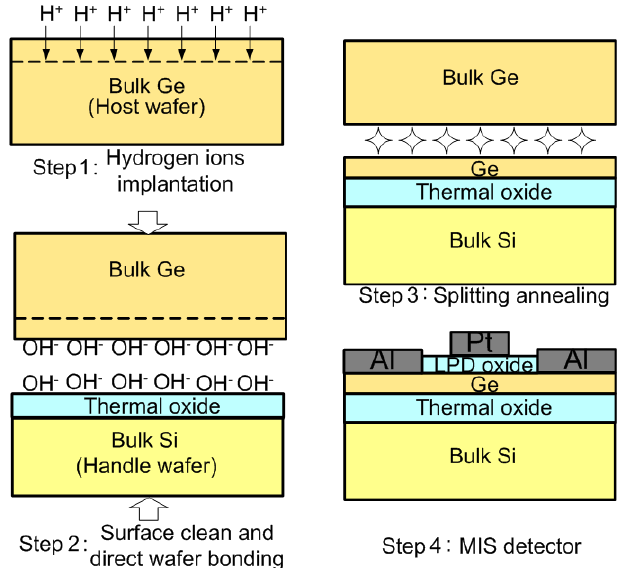
Figure 19. The smart-cut process flow for demonstrating the GOI MIS photodetector. Thin films of 0.8–1.3  m thick Ge were able to be transferred to the handle